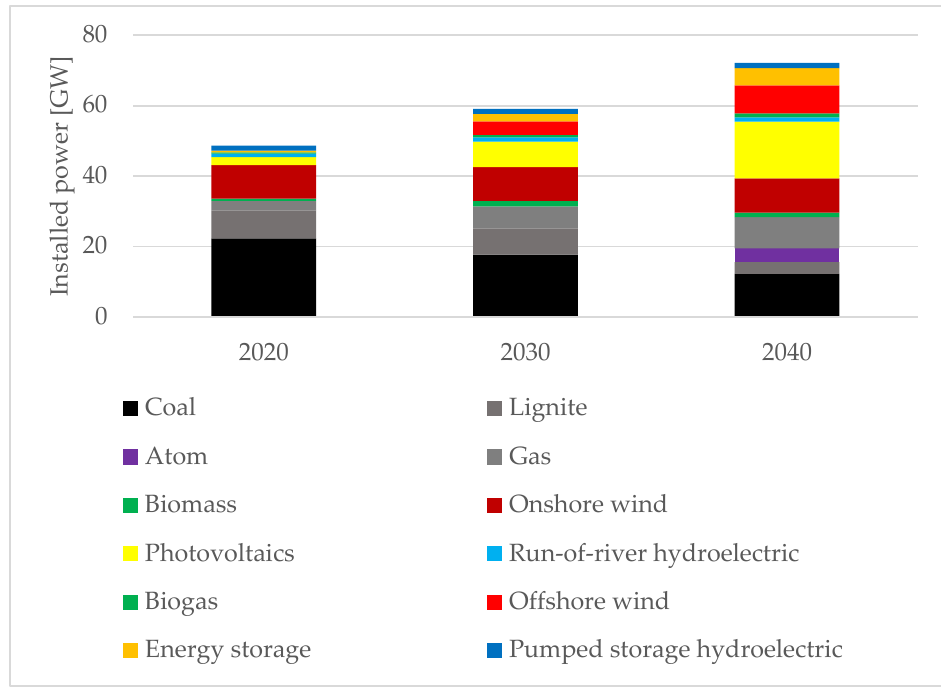
Figure 1. The structure of the planned installed capacity in Poland according to PEP2040 [12]. Key elements of